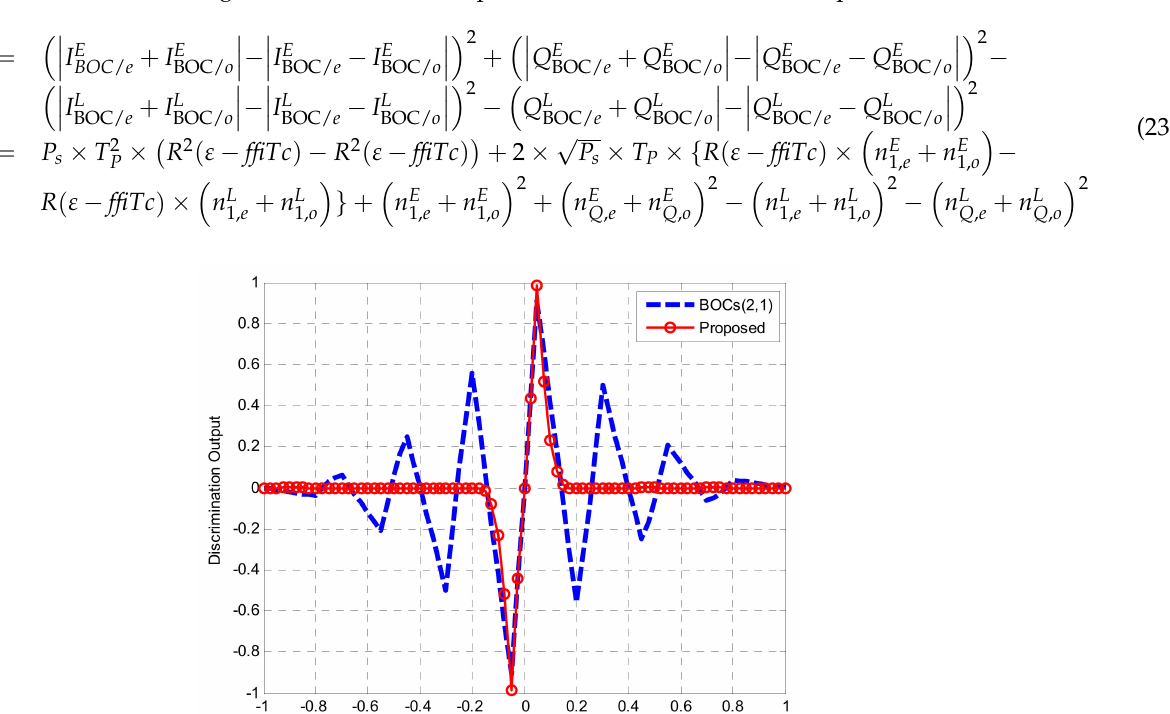
Figure 11. New delay tracking loop (DLL) architecture based on reconstruction correlation function. I and Q are short for in-phase and quadrature components. The subscript j contains o and e , and they represent the odd reference signal and even reference signal. R BOC/ j is the CCF of the locally received signal and reference signal, ε is code delay; δ Tc represents the correlator spacing; T P is the integration time; and E and L represent the correlation location (early(E), late(L)). n I , j and n Q , j are the Gaussian noise. Using the non-coherent early-late power (NELP) discriminator [27], depicted in Figure 12, the ultimate expression of the discriminator output is: